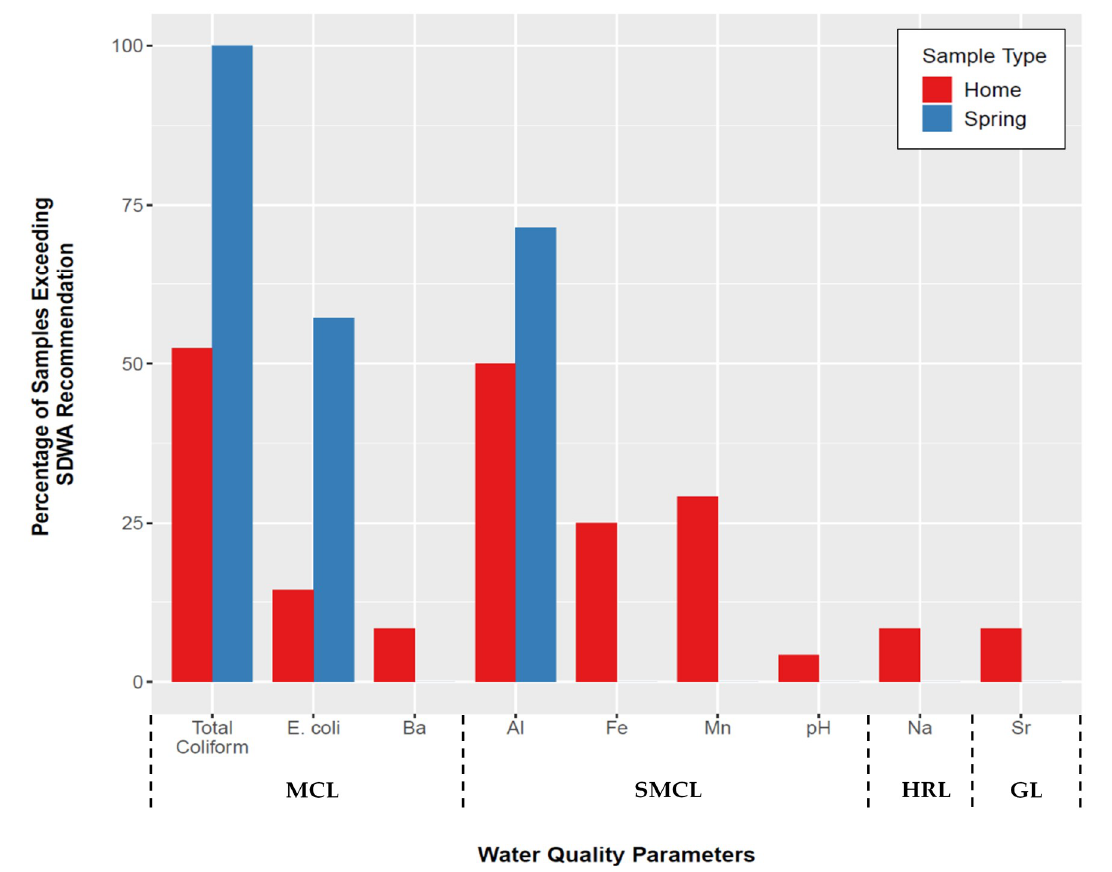
Figure 3. Percentage of home (n = 24) and spring (n = 7) samples exceeding Safe Drinking Water Act (SDWA) contaminant recommendations for detected constituents. For home samples, this data represents the highest concentrations detected between first- and second-draw samples. (MCL = Maximum Contaminant Level, SMCL = Secondary Maximum Contaminant Level, HRL = Health Reference Level, GL = Guidance Level).